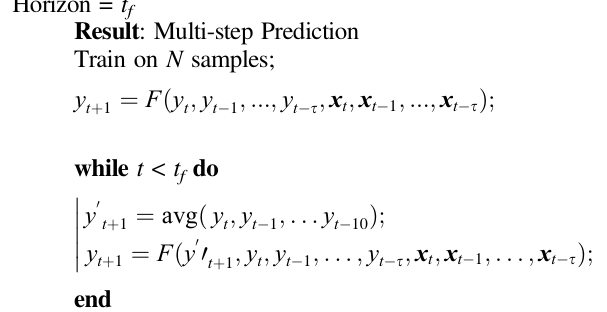
Algorithm 2 : Guided Closed Loop Prediction for Prediction